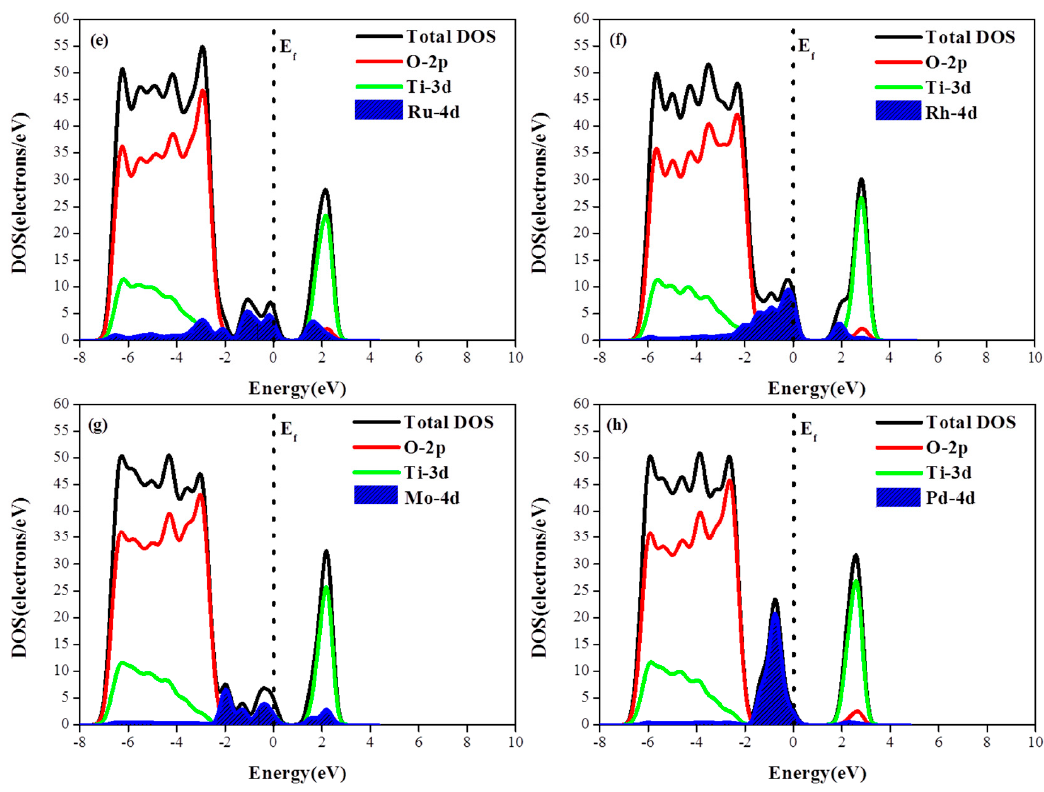
Figure 4. ( a – d ) Density of states of M (Pd, Ru, Mo, Rh)/TiO 2 (101) with the monoatomic structure; and ( e – h ) the density of states of M (Pd, Ru, Mo, Rh)/TiO 2 (101) with the diatomic structure.